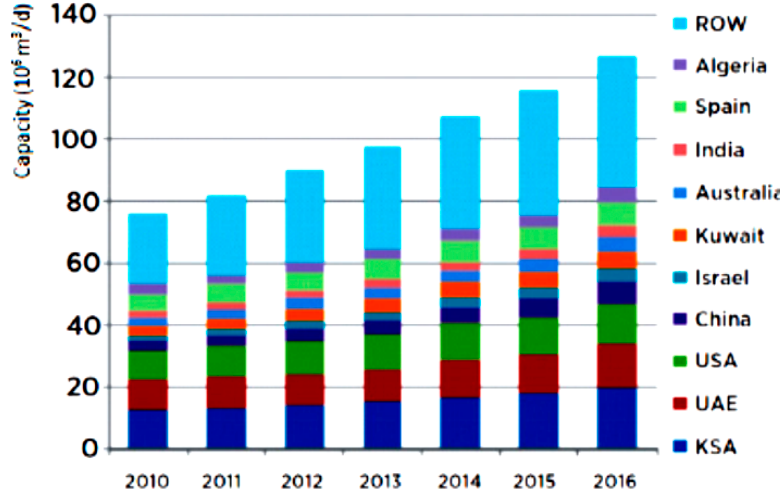
Figure 5. Global installed desalination capacity, year 2010–2016 [32].